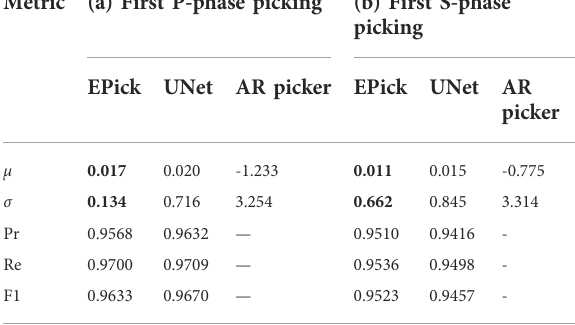
The bold values represent the best performances on the used